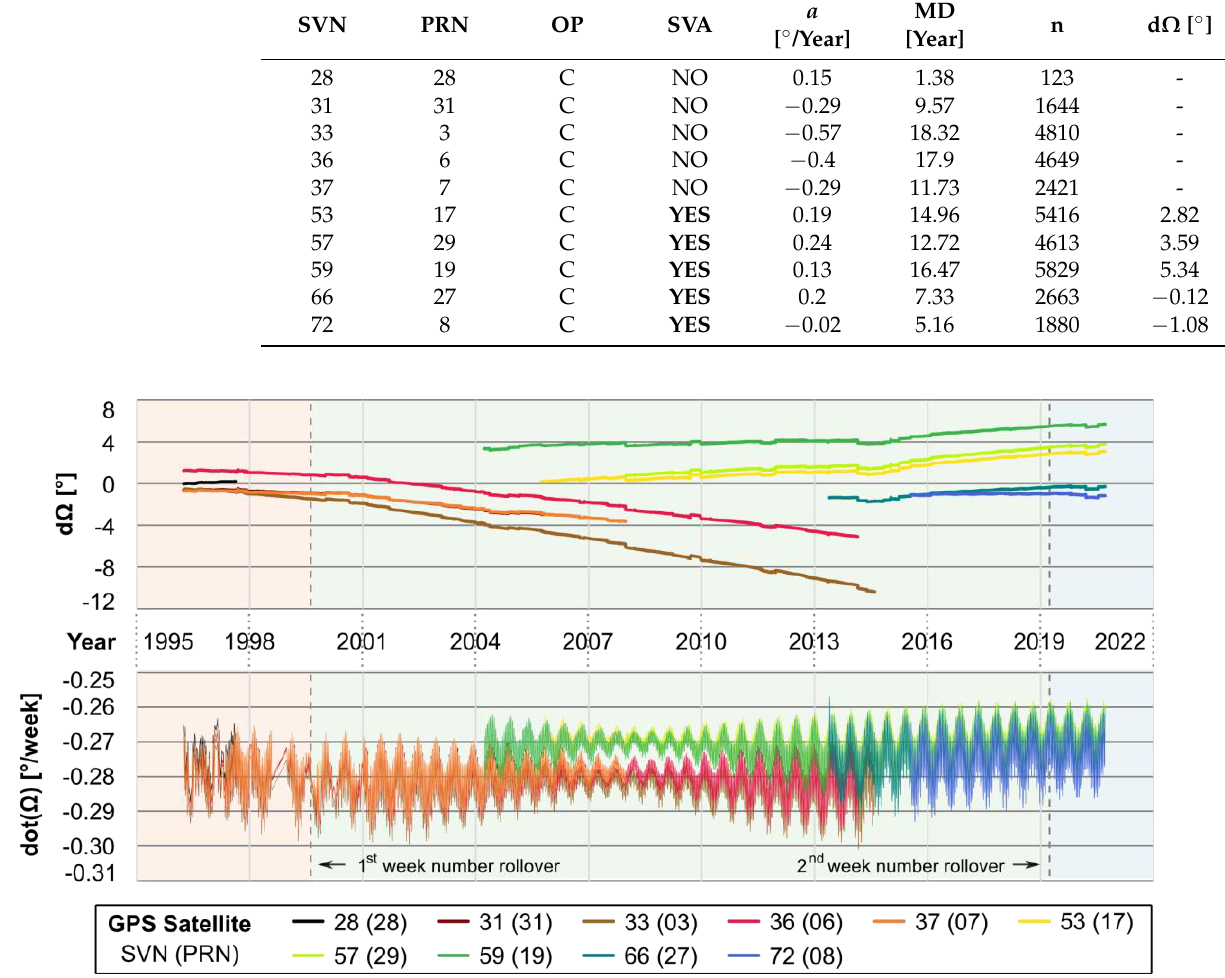
Figure A3. Separation of satellite ANs from the hex-LS-estimated position of the OP C AN with satellite dot(Ω) values. Table A4. Descriptive parameters of the OP E satellites.